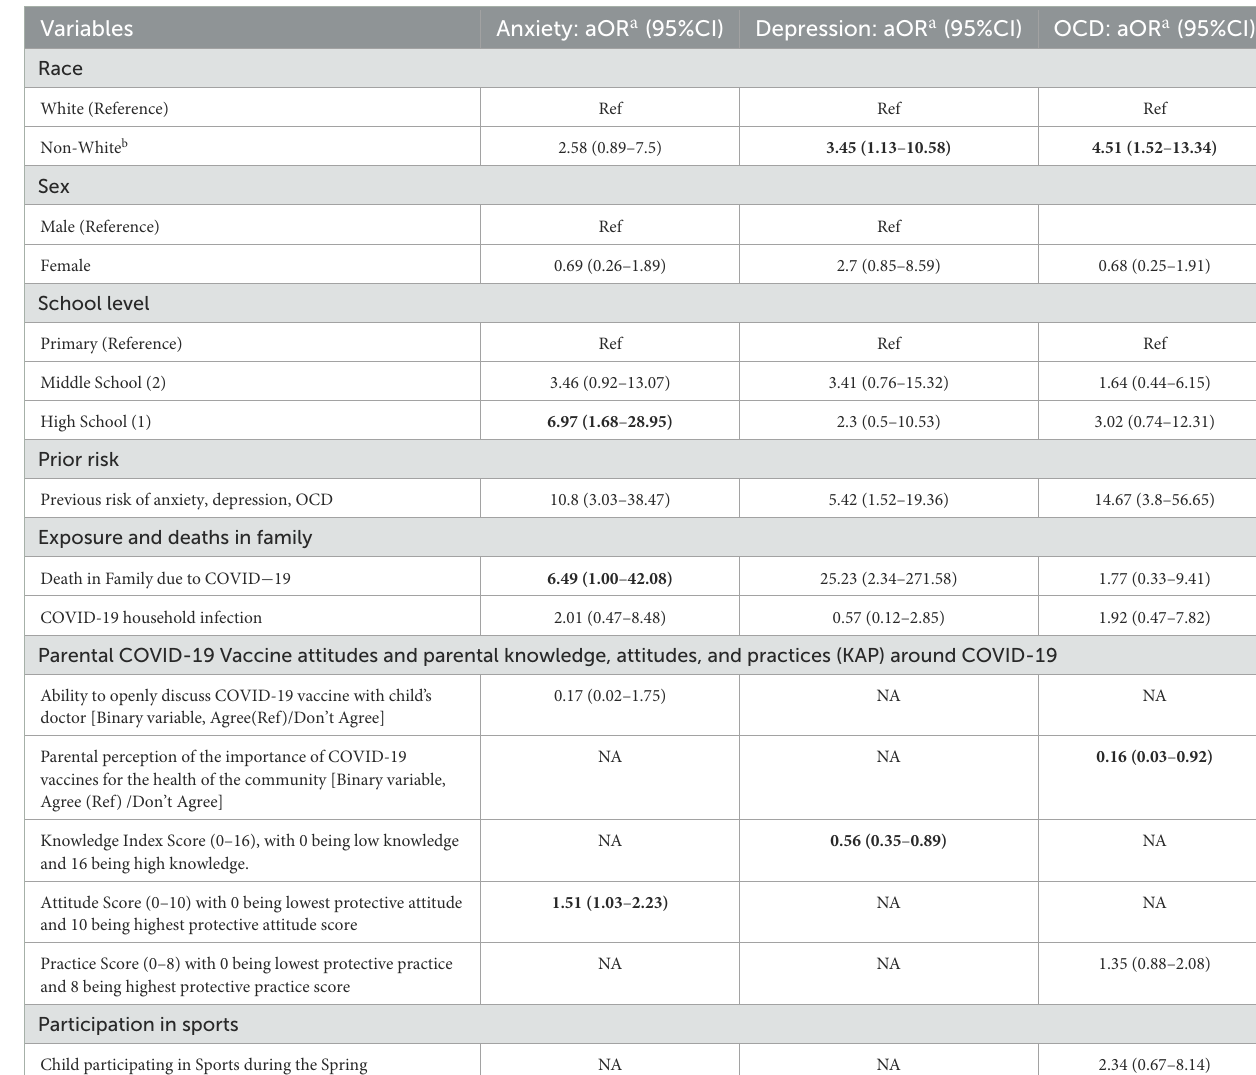
TABLE 2 Determinants of anxiety, depression, and OCD at timepoint 3